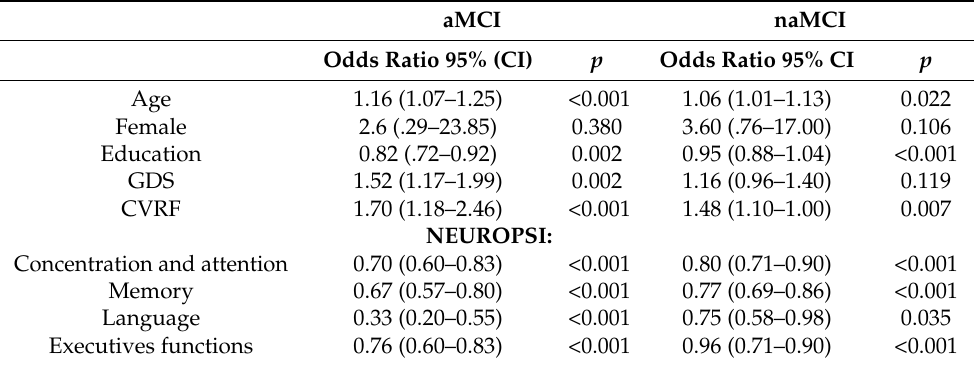
Table 2. Univariate multinomial logistic regression analysis of clinical and